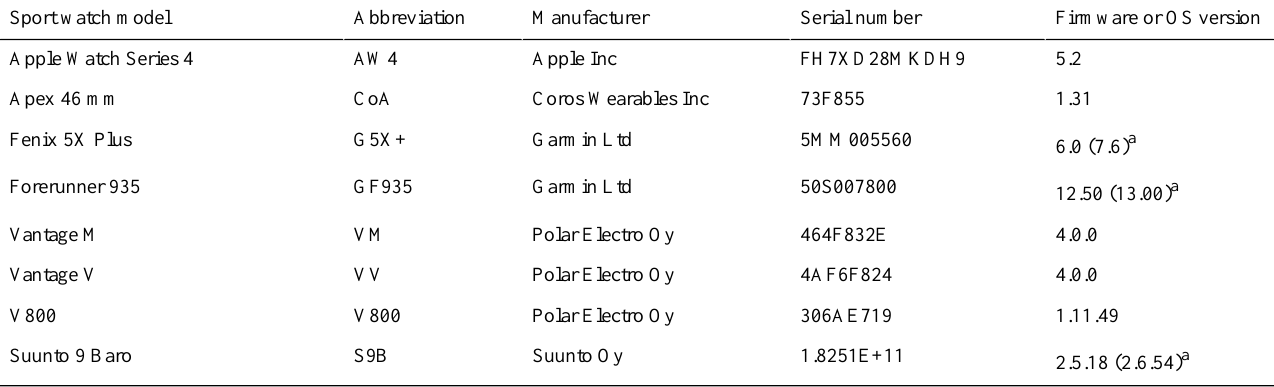
Table 1. Investigated sport watches and their